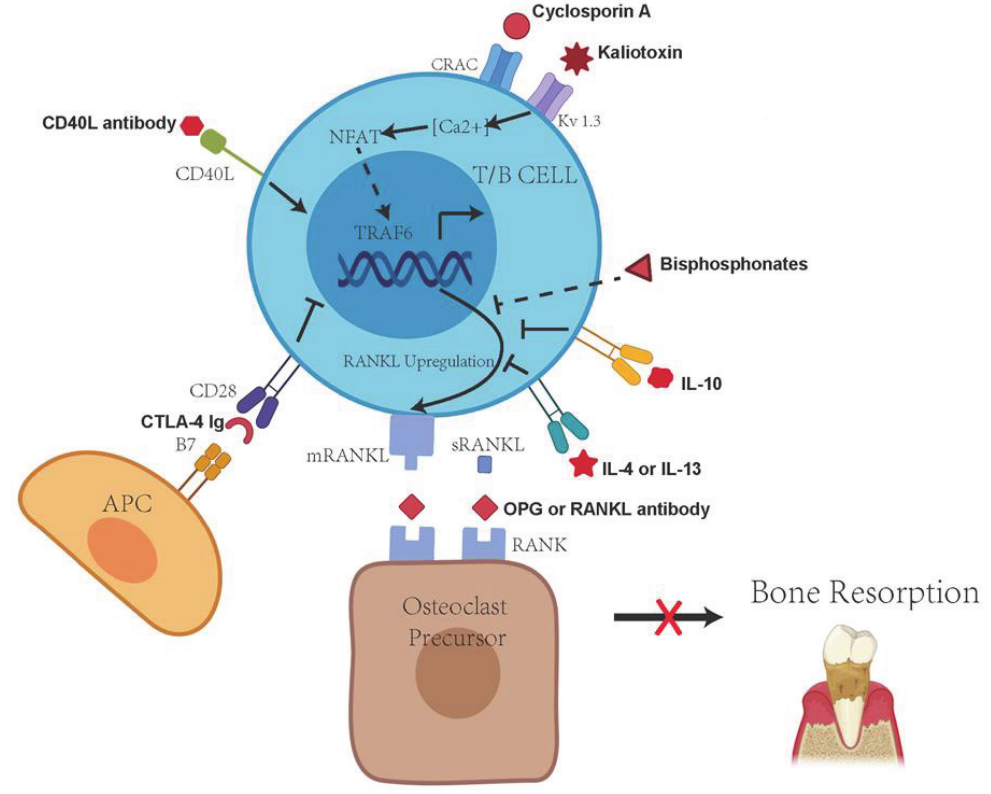
Figure 2. Potential immunological approaches to interfere with immune cell-mediated, RANKL-dependent periodontal bone resorption. The central target of these approaches is the inhibition of RANKL expression, secretion and interaction with RANK on osteoclast precursor cells. APC, antigen-presenting cell; CD40 L, CD40 ligand; CRAC, Ca2 + release-activated Ca2 + channels; IL-10, interleukin-10; mRANKL, membrane-bound RANKL; sRANKL, soluble RANKL; NFAT, nuclear factor of activated T cells; OPG, osteoprotegerin; RANK, receptor activator of nuclear factor κ B; RANKL, receptor activator of nuclear factor κ B ligand; TRAF6, tumor necrosis factor-receptor associated factor 6.